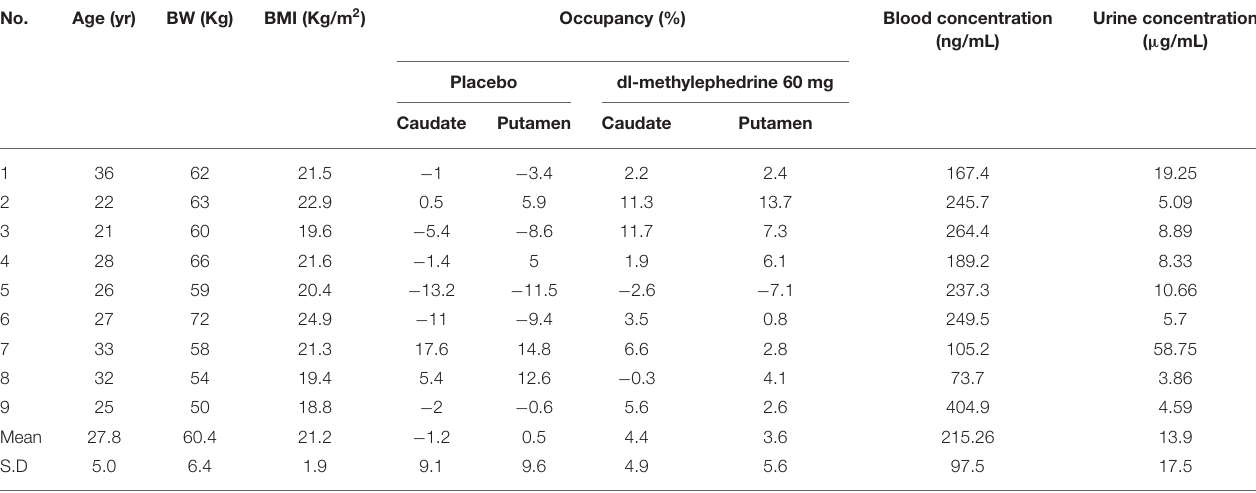
TABLE 1 | DAT occupancy in the striatum with placebo and dl-methylephedrine, and blood and urine concentrations of dl-methylephedrine. No.